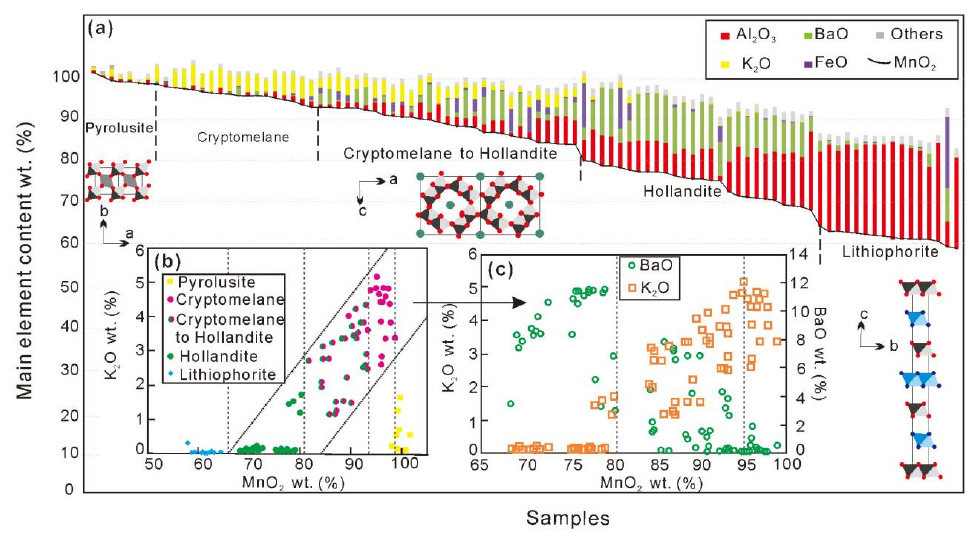
Figure 8. Element composition characteristics (data from EPMA) and corresponding crystal structures of main manganese oxide minerals in Xiangtan manganese deposit. ( a ) Column chart shows chemical variability of major elements in the identified Mn-oxide phases, and schematic drawing of the crystal structure is presented below correspondingly; red spheres represent O 2– , green for tunnel cations, blue for OH − ; ( b ) discrimination diagram of Mn oxide phases, according to selected elements (MnO 2 and K 2 O); ( c ) K 2 O and BaO content are negatively correlated in cryptomelane and hollandite.